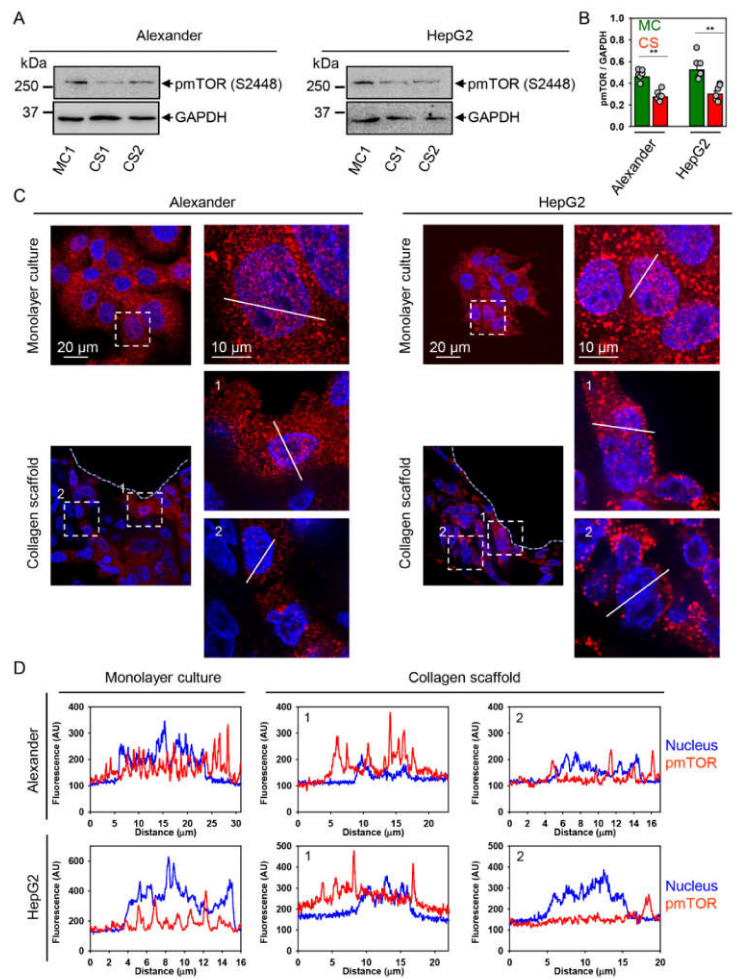
Figure 5. Mammalian target of rapamycin (mTOR) cytosolic translocation under culturing in collagen sca ff olds. ( A ) Expression of phosphorylated mTOR (pmTOR) was analyzed by immunoblotting. GAPDH—loading control. HepG2 and Alexander cells were grown either in standard monolayer culture (MC) or in collagen sca ff olds (CS). ( B ) Graphs show densitometric quantification of blots. HepG2 and Alexander cells were grown either in standard monolayer culture (MC) or in collagen sca ff olds (CS). The data are expressed as mean ± SEM, n = 4. (**) p < 0.01 denotes significant di ff erences with respect to monolayer culture. ( C ) Assessment of pmTOR sub-cellular localization. HepG2 and Alexander cells were grown either in standard monolayer culture or in collagen sca ff olds, then pmTOR (red) was labeled using antibody. Hoechst 33342 (blue) dye was used to counterstain nuclei. Labeled cells were imaged by confocal microscopy and the images were processed using ImageJ software (NIH). Inserts represent zoom regions. The dashed lines highlight the collagen fiber–cells interface. ( D ) Sub-cellular localization of pmTOR under culturing in collagen sca ff olds. Representative line scans of confocal microscopic images shown in ( C